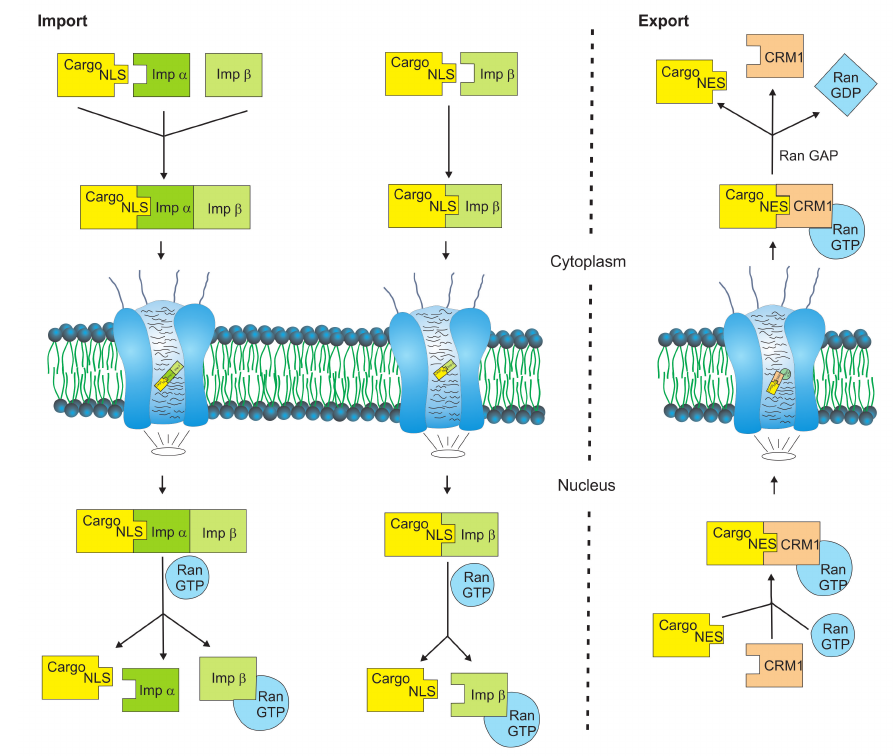
Figure 1. Simplified model of nuclear import and export processes. The transfer of cargo proteins (yellow) between nucleus and cytoplasm occurs through the nuclear pore complex and is mediated by members of the karyopherin superfamily. Nuclear import is mediated by importin β and importin α nuclear transport receptors (green). Some importin β s recognize their cargo proteins directly via a nuclear localization signal (NLS), while others require importin α adaptor proteins. Nuclear export mainly occurs via the transport receptor chromosome region maintenance 1 (CRM1) (light red) and depends on nuclear exclusion signals (NES) in the primary amino acid sequence of the cargo